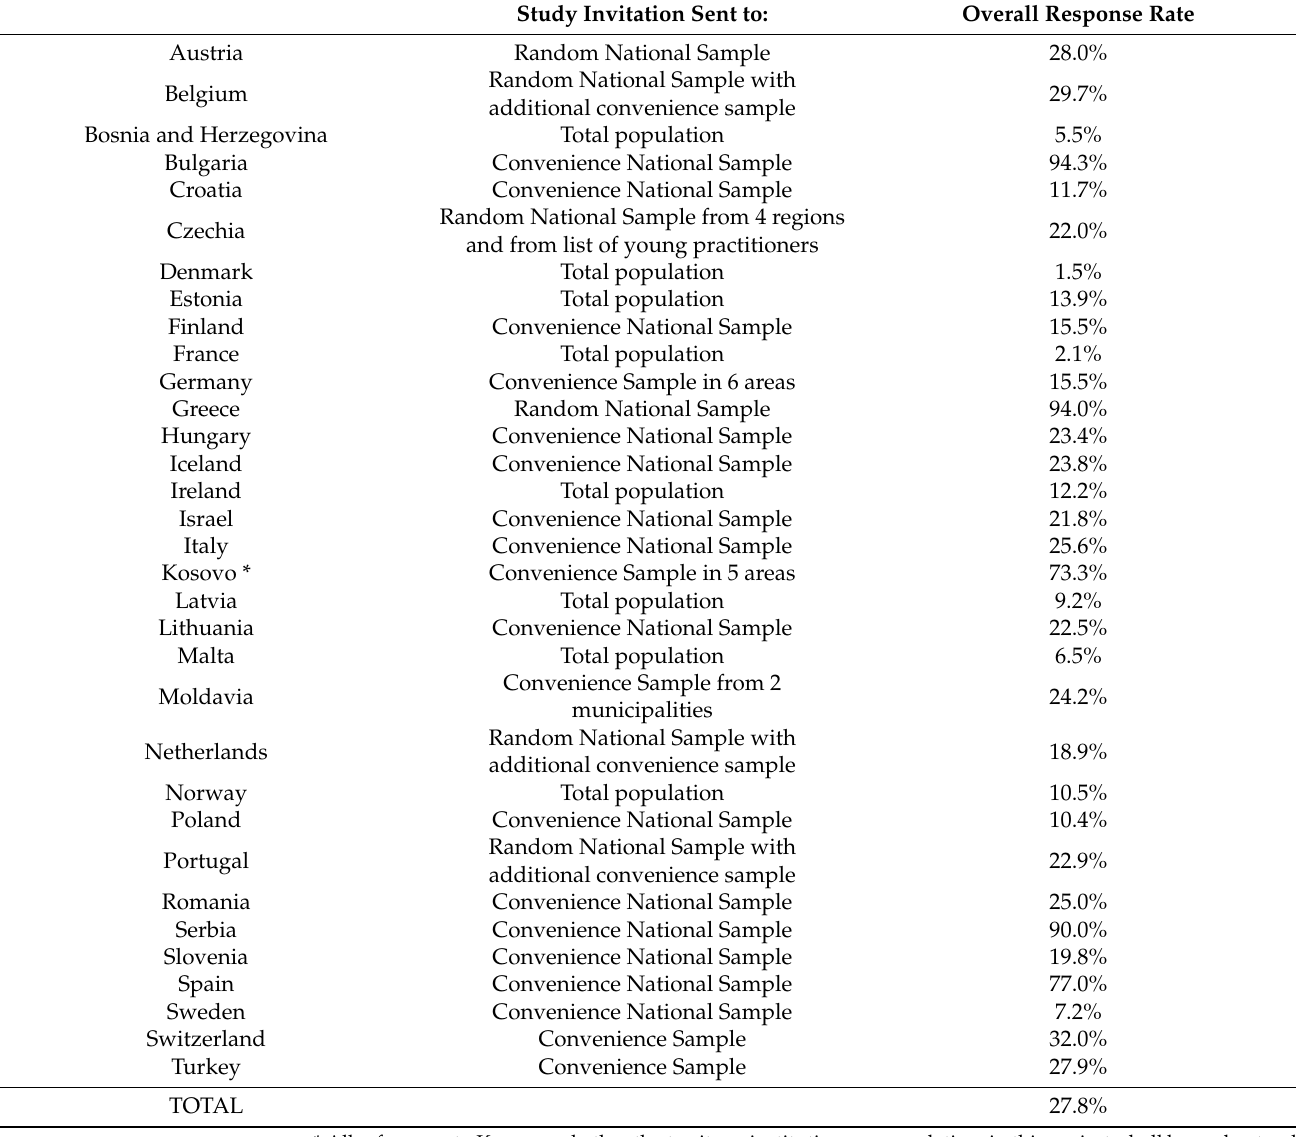
Table 1. Sampling method and overall response rate in each